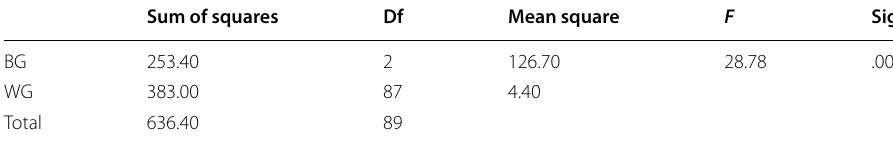
Table 9 Inferential statistics of speaking accuracy posttest of all groups Sum of squares Df Mean square Sig.